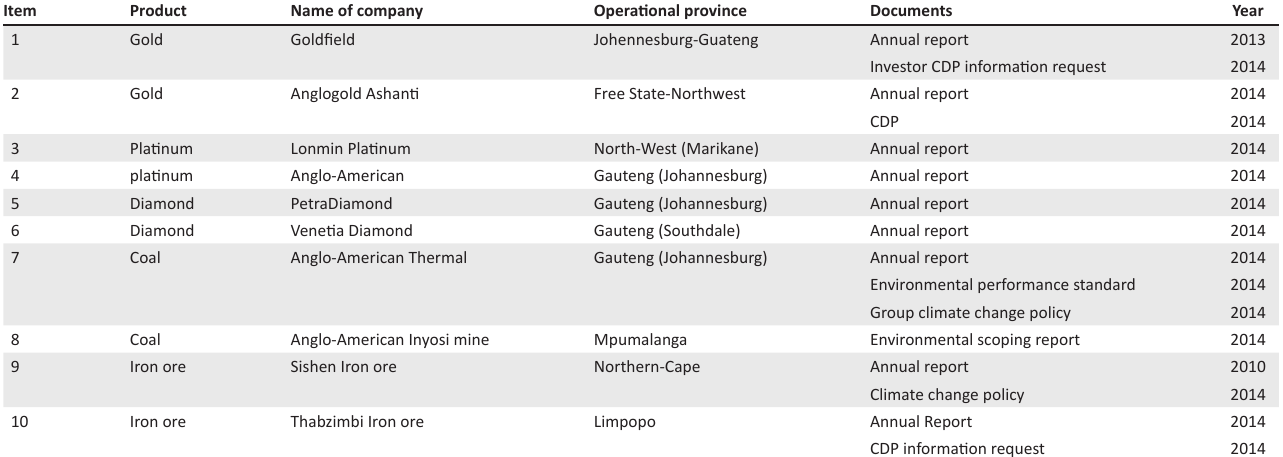
TABLE 2: Sample products, mining companies, province and reports. Item